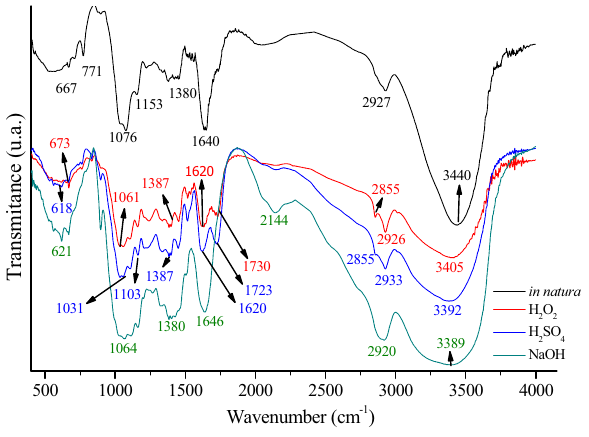
Fig. 2 Infrared spectrum of CNS in natura ( source : COELHO et al. 2014) and chemically modified with H 2 O 2 , H 2 SO 4 and NaOH Table 3 Surface area, volume of pore and pore radius for the shell of the cashew nut shell (CNS) chemically modified with H 2 O 2 , H 2 SO 4 and NaOH Parameters